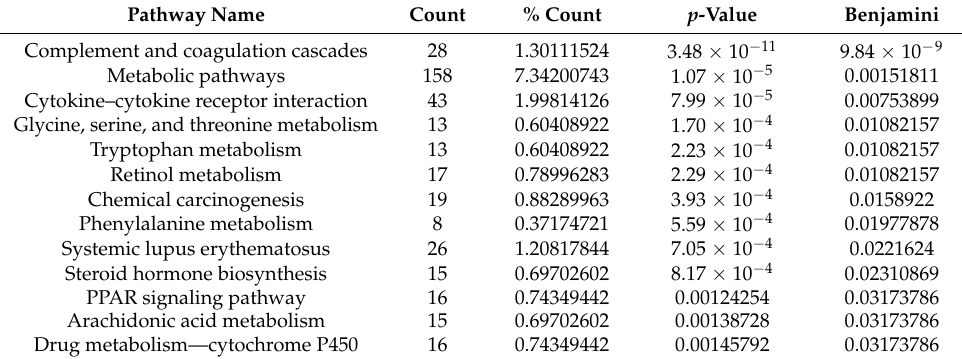
Table 4. K58-M using the Kyoto Encyclopedia of Genes and Genomes (KEGG) analysis; K58-M: fold change ≥ 2 upregulated 2243 genes (2152 genes*). * Number of genes corresponds to DAIVID.